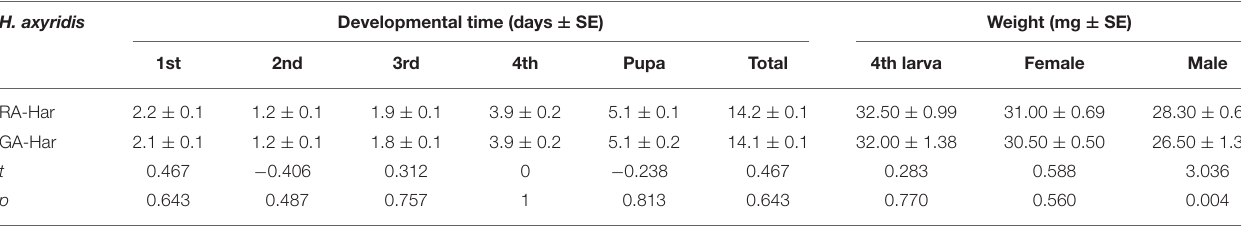
TABLE 1 | Pre-imaginal development time and the weights of fourth instars and newly emerged adults of H. axyridis . H. axyridis Developmental time (days ± SE) Weight (mg ± SE) 1st 2nd 3rd 4th